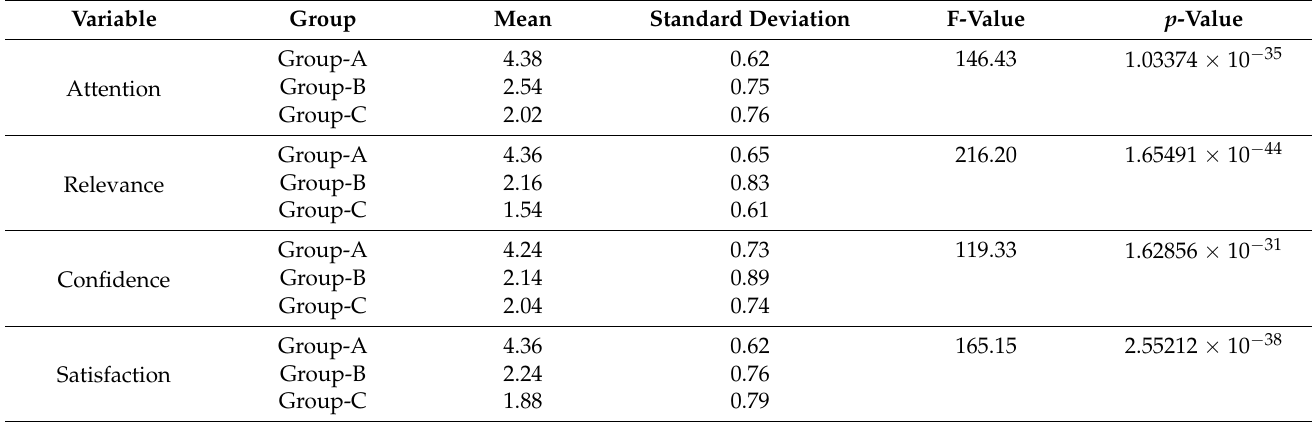
Table 3. One-way ANOVA test results for different variables of the ARCS motivational